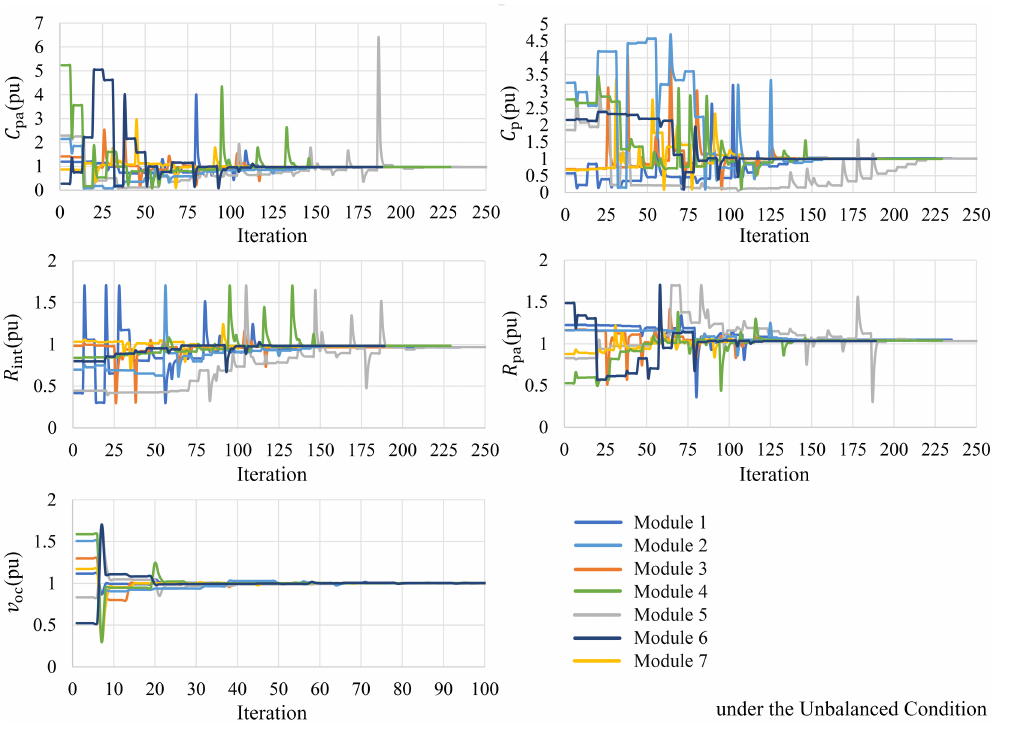
Figure 10. Estimation process of the five battery parameters for the seven modules under the unbalanced condition.